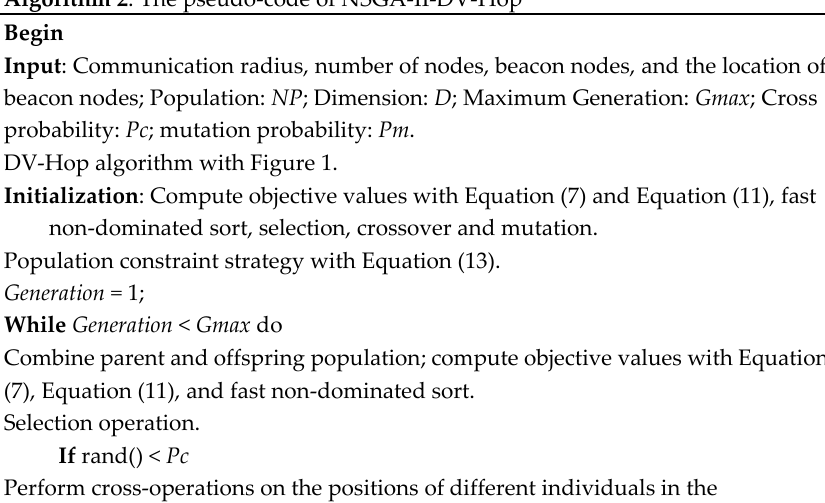
Algorithm 2 : The pseudo-code of